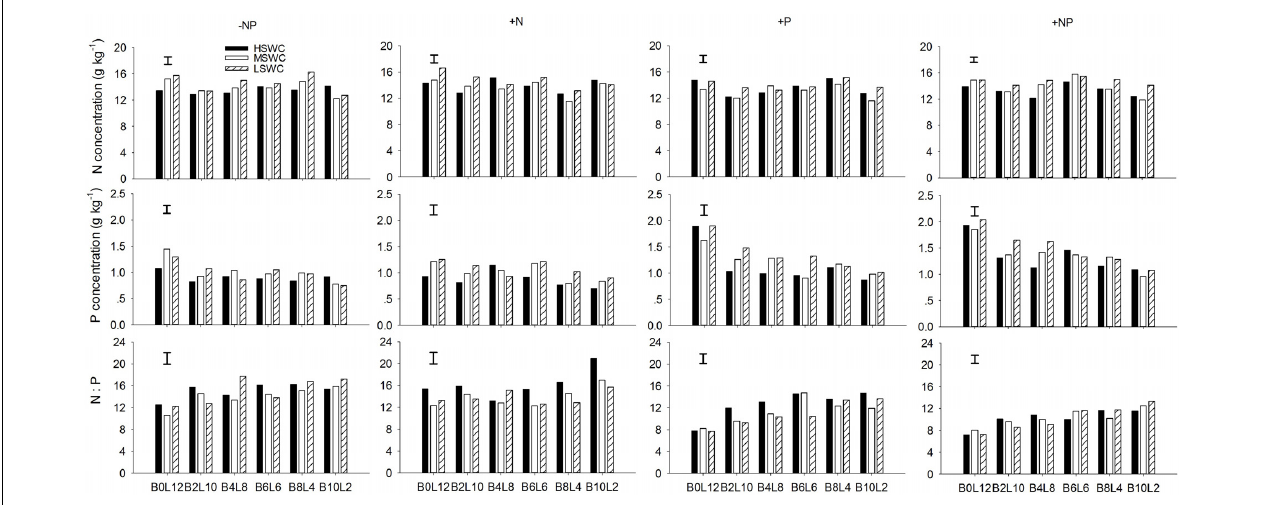
FIGURE 4 | Whole plant N concentration, P concentration and N:P ratio of L. davurica (L) mixed with B. ischaemum (B) at various mixture proportions under three soil water regimes [HSWC: 80% FC (field capacity); MSWC: 60% FC; LSWC: 40% FC] and four fertilization treatments (–NP, +N, +P, +NP). B i L j ( i , j = 0, 2, 4, 6, 8, 10, 12; i + j = 12) means the plant numbers of B. ischaemum to L. davurica in their mixtures. Error bars are LSD ( p <